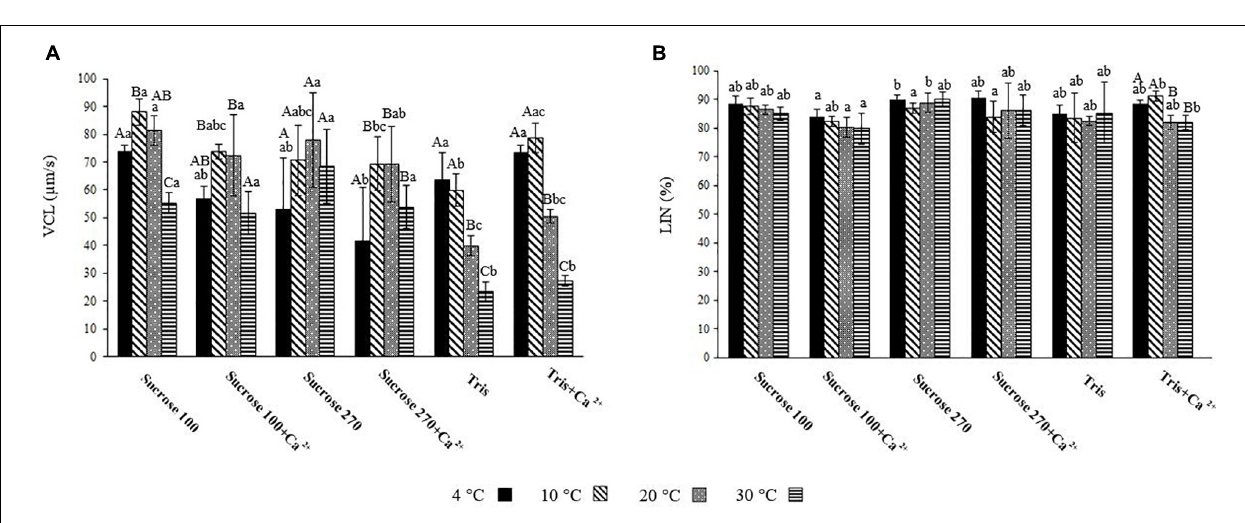
FIGURE 3 | (A) Curvilinear velocity (VCL) of L. lota spermatozoa at 15 s post-activation at 4, 10, 20, and 30 ◦ C in Tris; Tris + Ca 2 + ; Suc 100; Suc 100 + Ca 2 + ; Suc 270; and Suc 270 + Ca 2 + . (B) Linearity (LIN) of L. lota spermatozoa at 15 s post-activation at 4, 10, 20, and 30 ◦ C in Tris, Tris + Ca 2 + ; Suc 100, Suc 100 + Ca 2 + , Suc 270, and Suc 270 + Ca 2 + . Different uppercase letters indicate significant difference ( P < 0.05) among studied temperatures in each solution. Different lowercase letters indicate significant difference ( P < 0.05) among studied solutions at each temperature. Data are expressed as mean ± SD. Values with the same superscript do not differ significantly ( P >